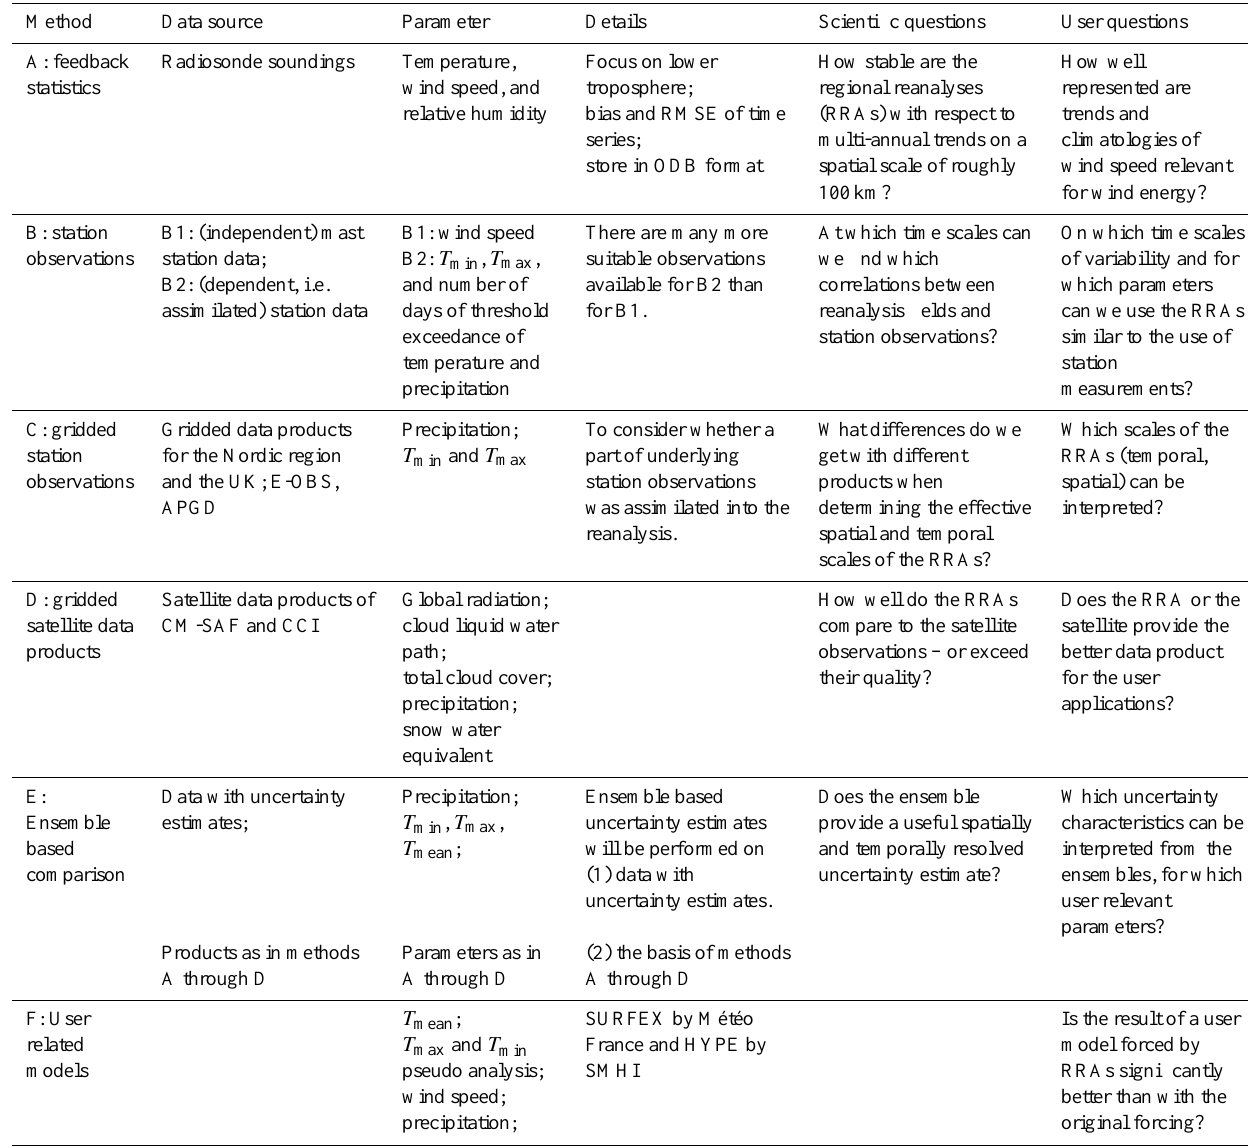
Table 2. Methods and data sources suitable to derive uncertainty estimates for regional